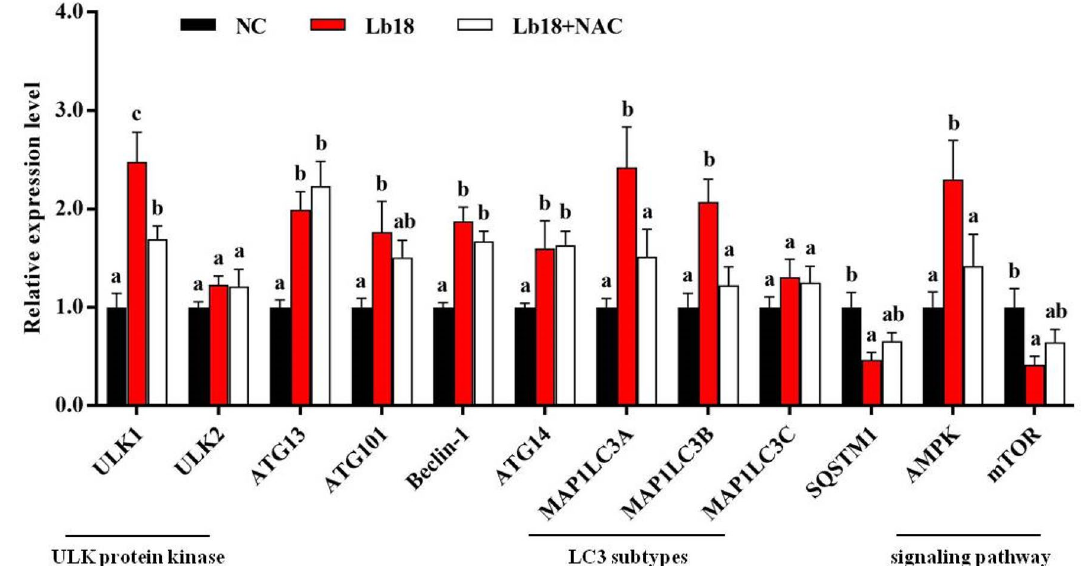
Figure 4. Relative expression of autophagy-related genes and AMPK-mTOR signaling pathway in the muscle of different groups. Values represent the mean ± S.E. (n = 3 replicate tanks), 3 turtles were sampled for each tank, the data with different letters show significant difference ( p < 0.05).